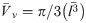
Point sampled intercept method for measuring volume weighted mean umbrella cell volume.Representative image taken from adult urinary bladder stained with Rhodamine Phalloidin (to outline cell borders). After the grayscale image was inverted (and randomly rotated), a grid (shown as vertical and horizontal intersecting blue lines) was superimposed onto each image and intersections of grid lines were counted as vertices when they fell within the profile of an umbrella cell (examples illustrated by red dots). The horizontal distance along each grid line that spanned the boundary of the umbrella cell (shown by yellow lines) was measured for each cell. The distance of the yellow line in the top umbrella cell was counted twice because two profiles (shown by red dots) fell within that cell. As described in the methods, the length of the intersection was converted to volume-weighted mean cell volume using the following formula: V¯v=π3(l3¯).